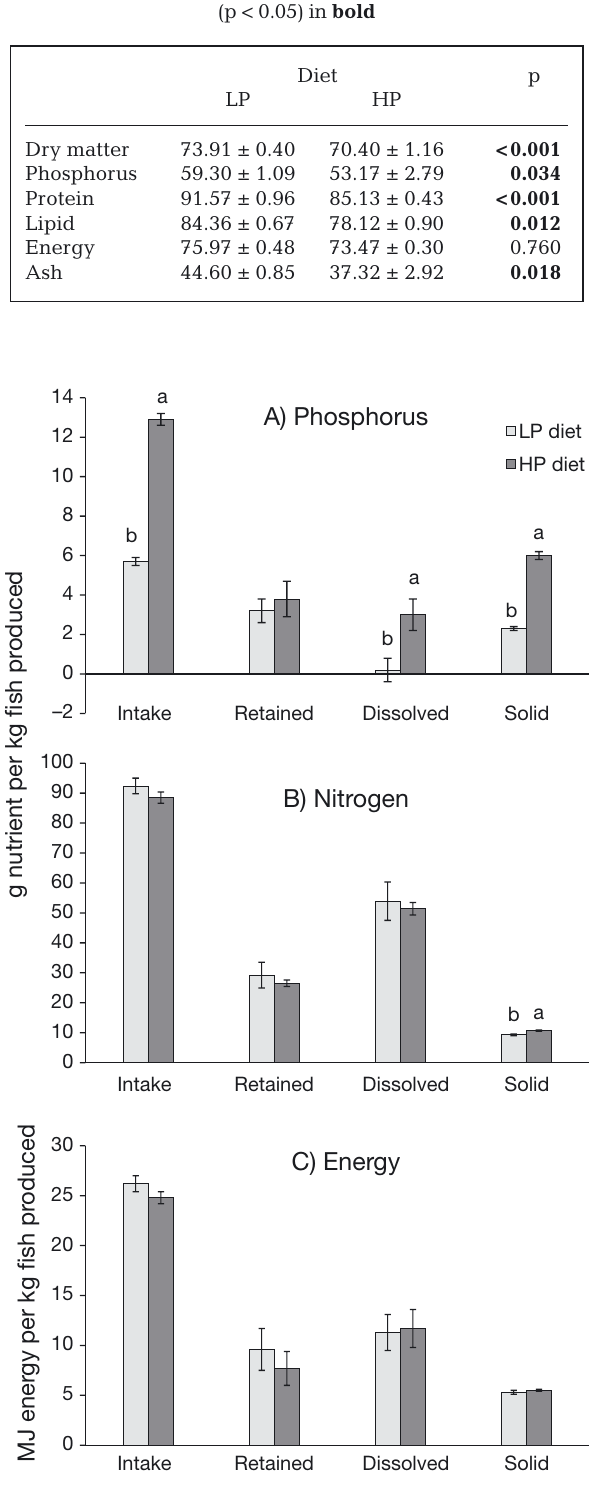
Fig. 1. Oncorhynchus mykiss . (A) Phosphorus, (B) nitrogen and (C) energy intake, retention and loading estimated at the end of the feeding trial from larger rainbow trout fed low- phosphorus (LP) and high-phosphorus (HP) diet. Mean values (n = 4 tanks per diet) in a column with different superscripts are significantly different (p < 0.05). For calculations of nutri- ent retention, see Eq. (5) in ‘Materials and methods’; solid nu- trient load, see Eq. (6); and dissolved nutrient load, see Eq.